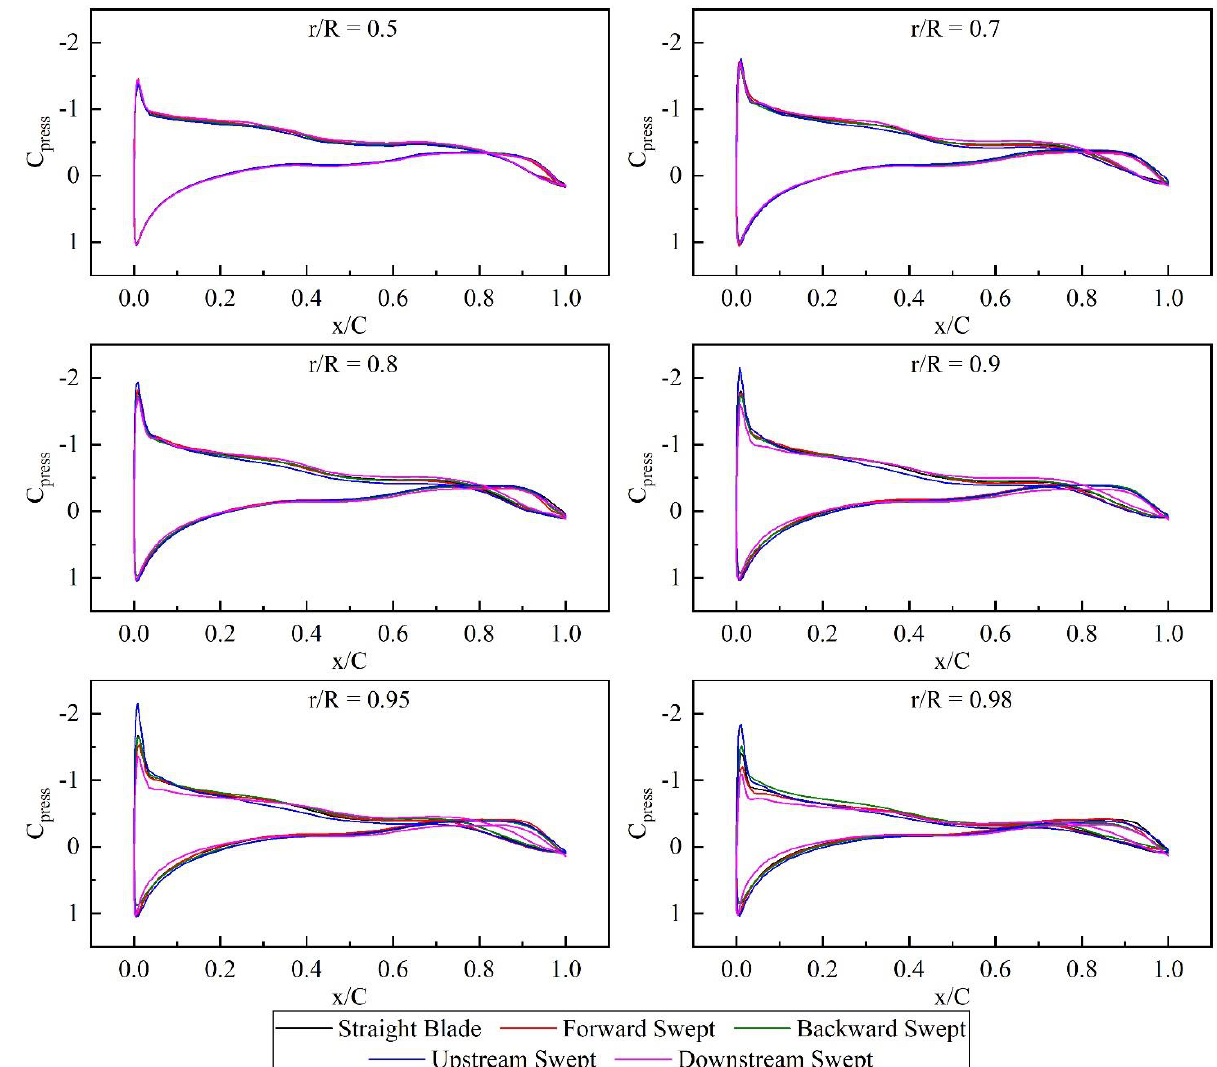
Figure 14. Pressure Coefficient distributions on diverse blade sections at TSR = 9.